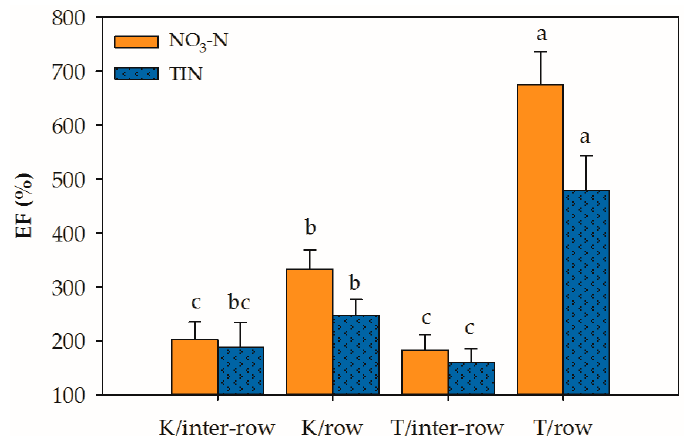
Figure 3. Enrichment factor (EF) and standard error for soil NO 3 –N and soil inorganic N (TIN) following row establishment as a function of band herbicide (K) or zone till (T) row establishment and zone (row or interrow). Columns with the same letter are not significantly different at p ≤ 0.05.